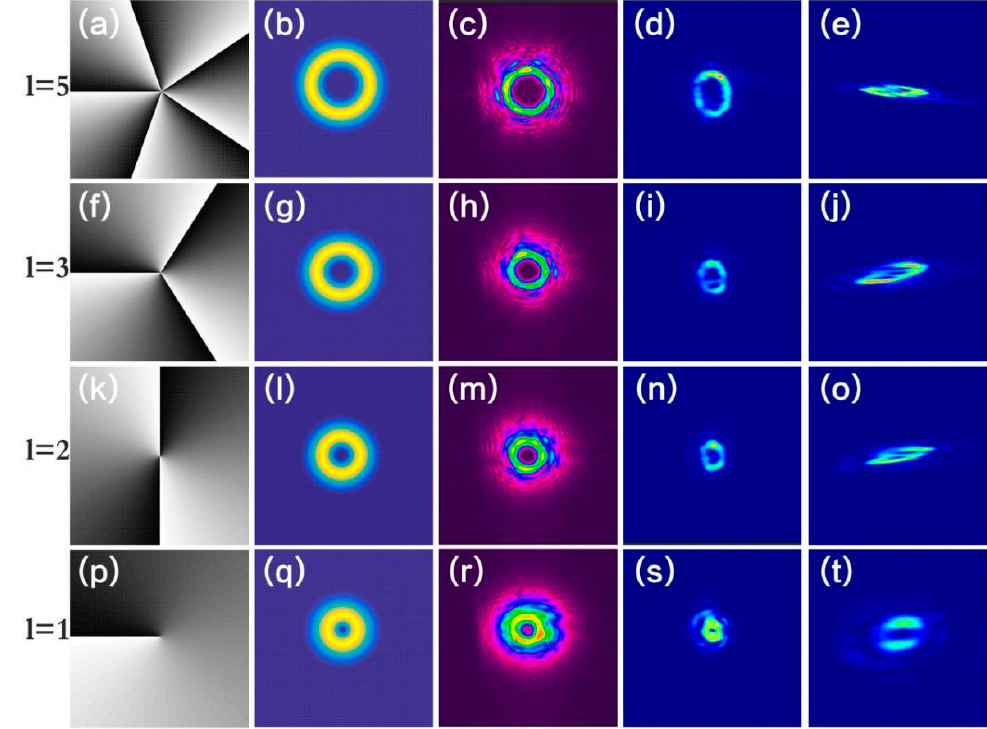
Figure 4. The experimental and theoretical output power of output light as a function of the topo- logical charge of vortex light at 780 nm, where the pump power at 1950 nm is 180 mW and the power at 780 nm is 6 mW.